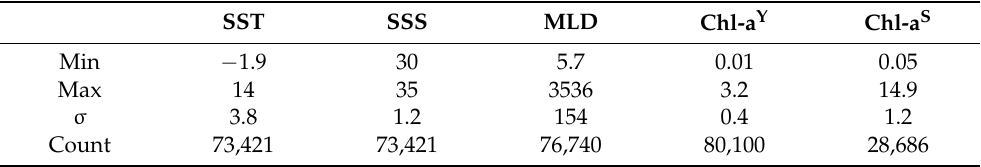
Table 1. Statistical values of input parameters: SST is sea surface temperature ( ◦ C), SSS is salinity (unitless), MLD is the upper ocean mixing layer depth (m), Chl-a Y is chlorophyll-a concentrations (mg m − 3 ) from re-analysis, while Chl-a S is chlorophyll-a concentrations (mg m − 3 ) from ESA. SST SSS MLD Chl-a Y Chl-a S Min −